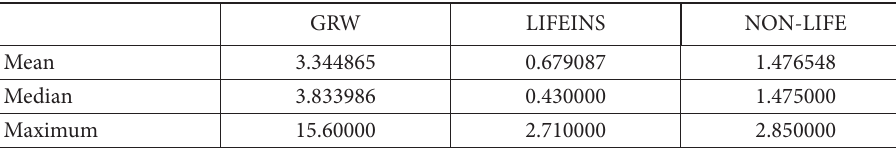
Table 2. Descriptive statistics (source: own processing)